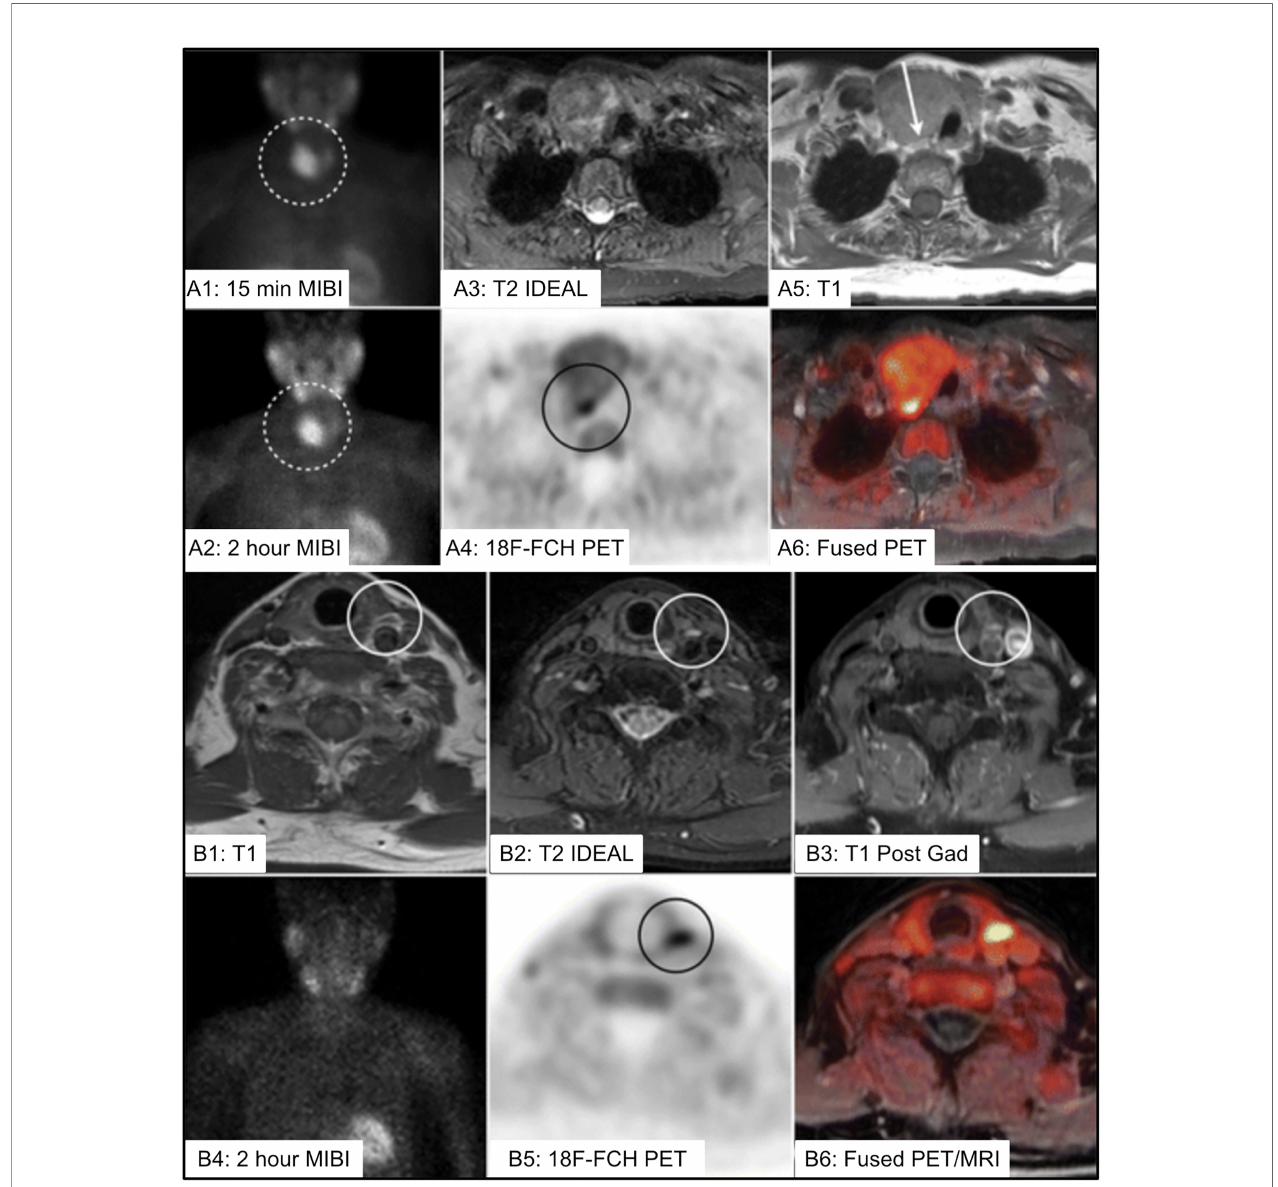
FIGURE 13 | (A) 73 yo F with multinodular goiter and 5cm dominant nodule [ (A1, A2) , dotted circle] with uptake on 99mTc-sestamibi (MIBI) limiting ability to localize the PA. 18F-FCH PET/MR imaging identi fi ed PA posterior to the dominant nodule (A3 – A6) [ (A4) , black circle, (A5) , white arrow]. (B) 75 yo F with left PA identi fi ed on 4DMRI [ (B1 – B3) , white circle], with inconclusive MIBI scan (B2) , and correlative increased 18F-FCH uptake within the PA on PET/MRI imaging (B5, B6) [ (B5) , black circle]. IDEAL, Iterative decomposition of water and fat with echo asymmetry and least-squares estimation; 18F-FCH, 18F- fl uorocholine; MIBI, 99mTc-sestamibi; PA, parathyroid adenoma. Reproduced with permission from: Kluijfhout WP, Pasternak JD, Gosnell JE, Shen WT, Duh QY, Vriens MR, de Keizer B, Hope TA, Glastonbury CM, Pampaloni MH, Suh I. 18F Fluorocholine PET/MR Imaging in Patients with Primary Hyperparathyroidism and Inconclusive Conventional Imaging: A Prospective